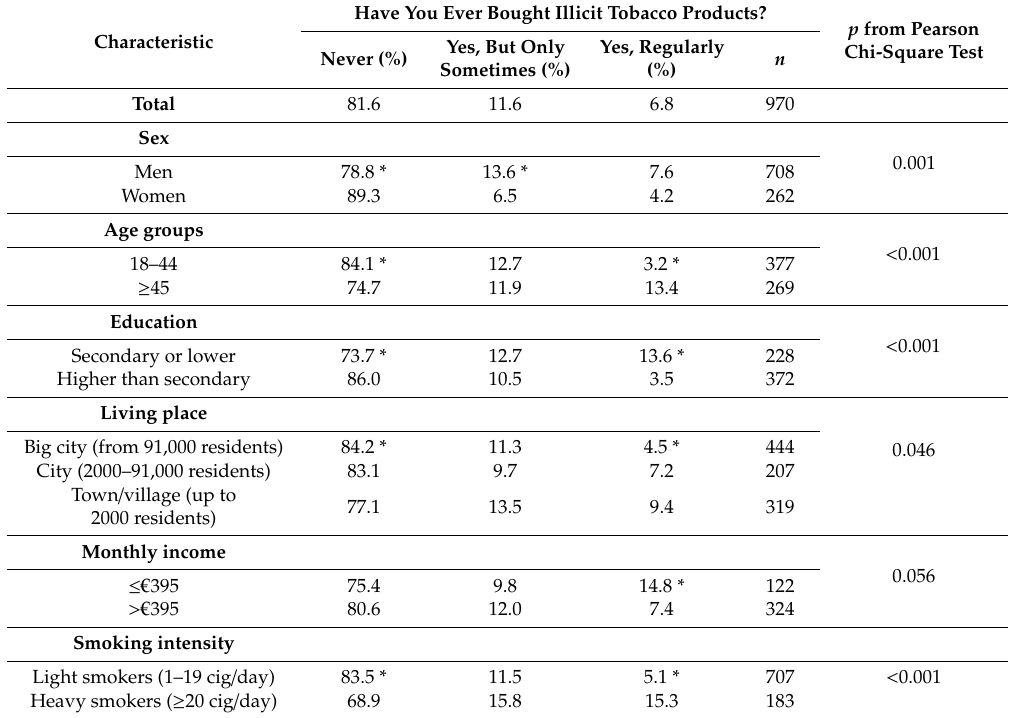
Table 2. Distribution of illicit tobacco purchase by selected socio-demographic characteristics and smoking intensity.